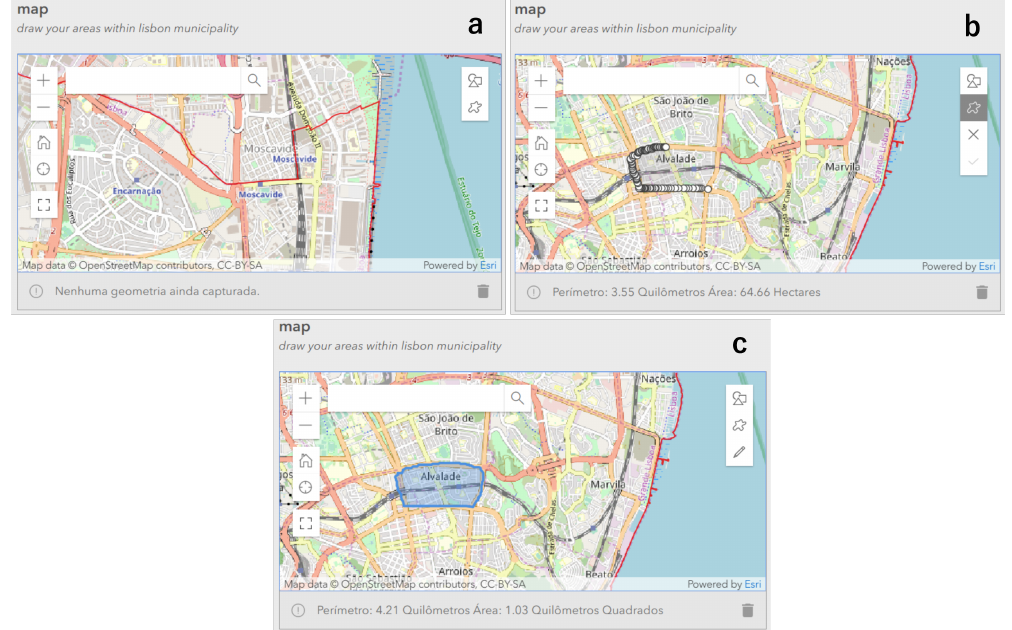
Figure 1: Drawing polygons on the survey: (a) Lisbon’s municipality perimeter as the red line; (b) freehand option; (c) final